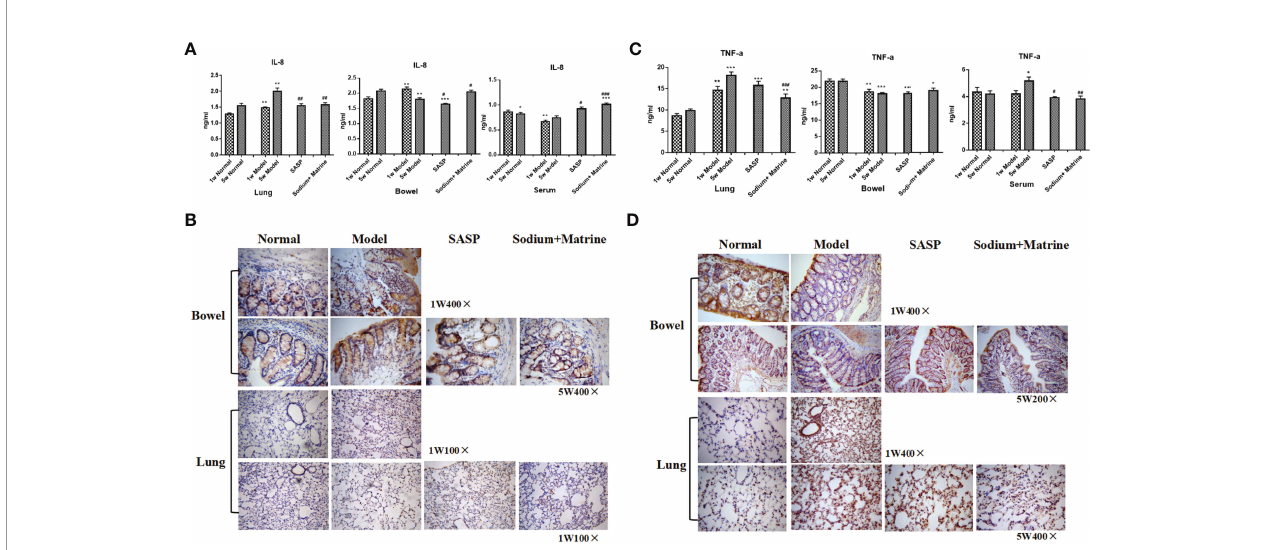
FIGURE 3 | ExpressionofTNF-a,IL-8 inthelung, bowel, andserum.UC models wereestablishedwiththemucous membraneofcolonallergizecombinedwithTNBS-alcohol enteroclysis. (A) ExpressionofTNF-a(Radioimmunoassay); (B) ExpressionofIL-8(Radioimmunoassay); (C) ExpressionofTNF-a(Immunohistochemistry); (D) ExpressionofIL-8 (Immunohistochemistry).ComparedwithNormalgroup,*P< 0.05;**P< 0.01; ***P<0.001.Comparedwithmodelgroup, #P <0.05,##P<0.01 , ### P<